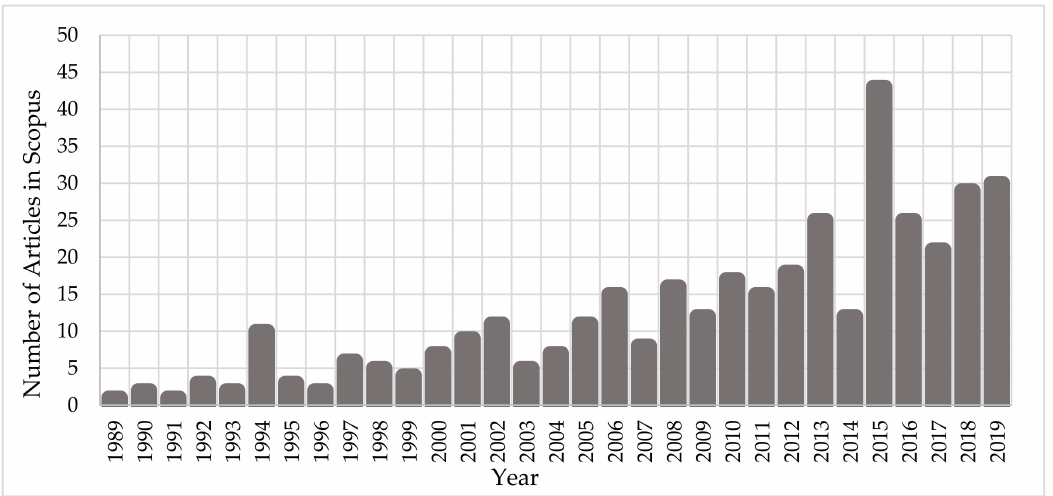
Figure 1. Number of published articles, over the last 30 years, on “Monte Carlo simulations” for the investigation of “DNA